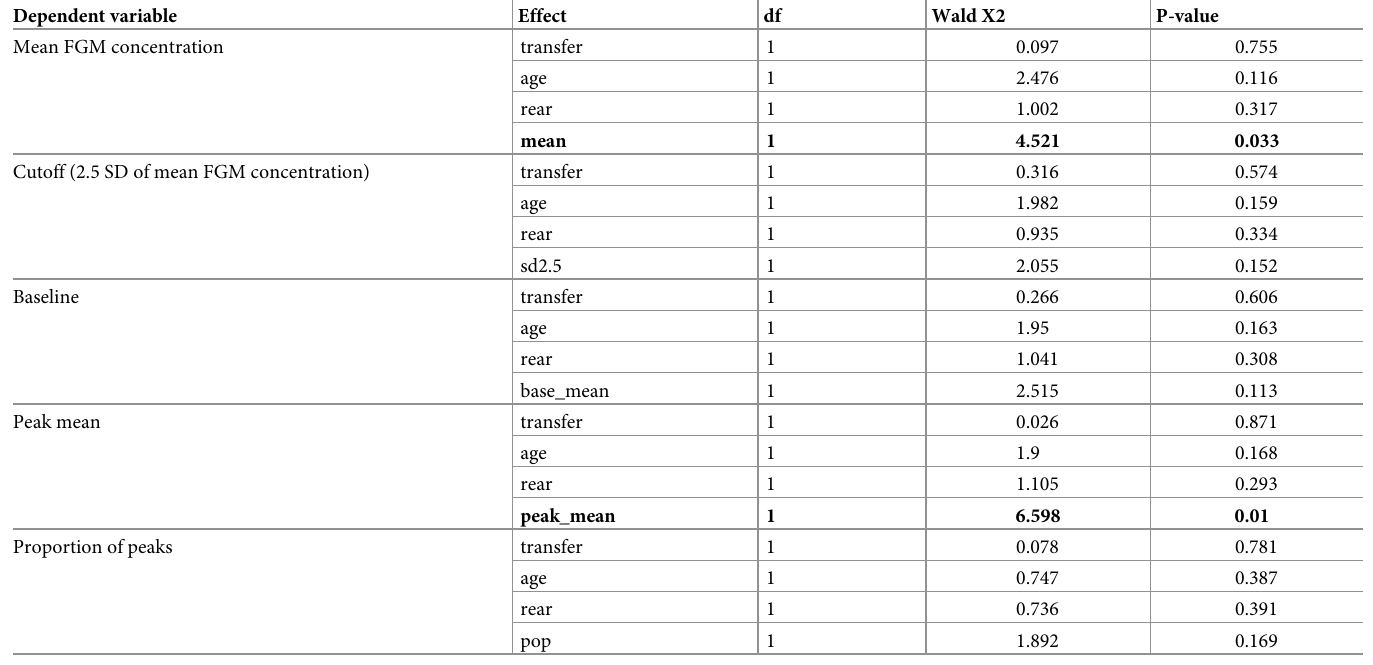
Table 4. GLMM results. Five fecal glucocorticoid metabolite (FGM) measures were calculated in fishing cats (n = 24) during institutional transfers and breeding intro- ductions that took place between 2010–2013. Mean and Peak mean FGM were both significant predictors of individuals exhibiting successful copulations.